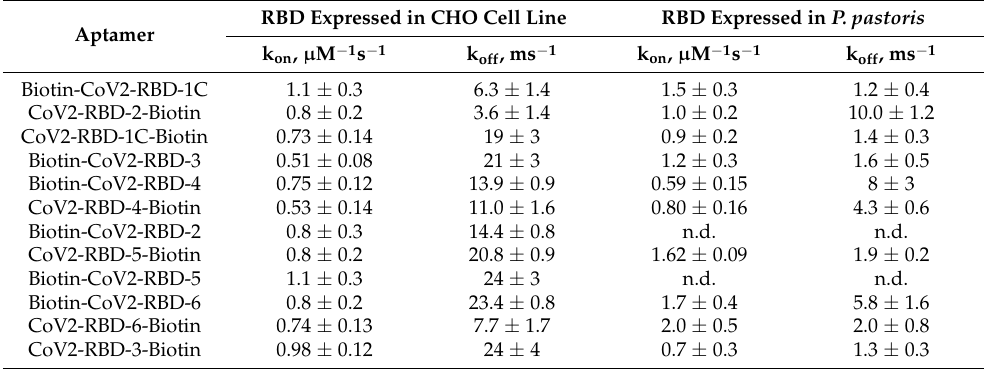
Table 2. Estimated association kinetic constants (k on ) and dissociation kinetic constants (k off ) for aptamer–RBD complexes. Aptamers are ranged according to maximal signal of the binding curves for RBD protein expressed in CHO cell line. n.d.—not